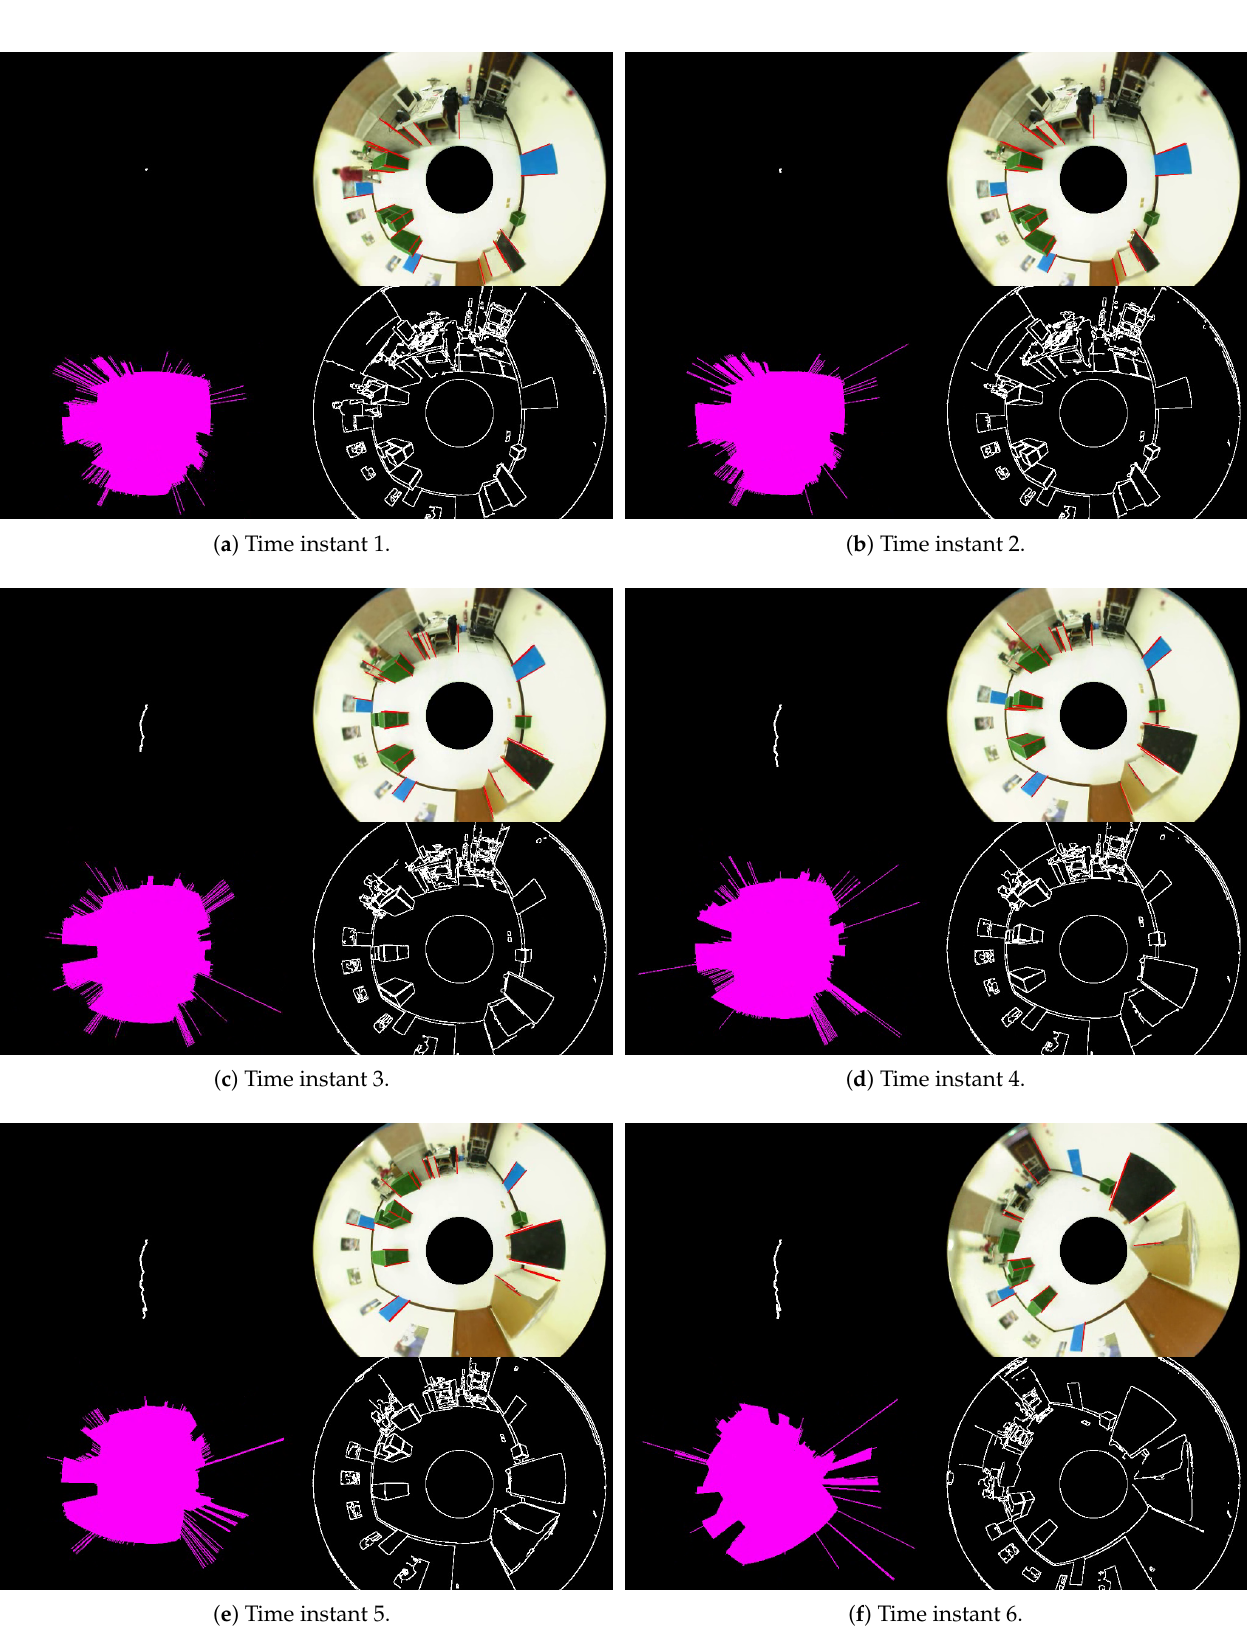
Figure 14. The examination of the localization process. It consists of the vertical line identification, edge detection, ground region segmentation, and trajectory computation for various